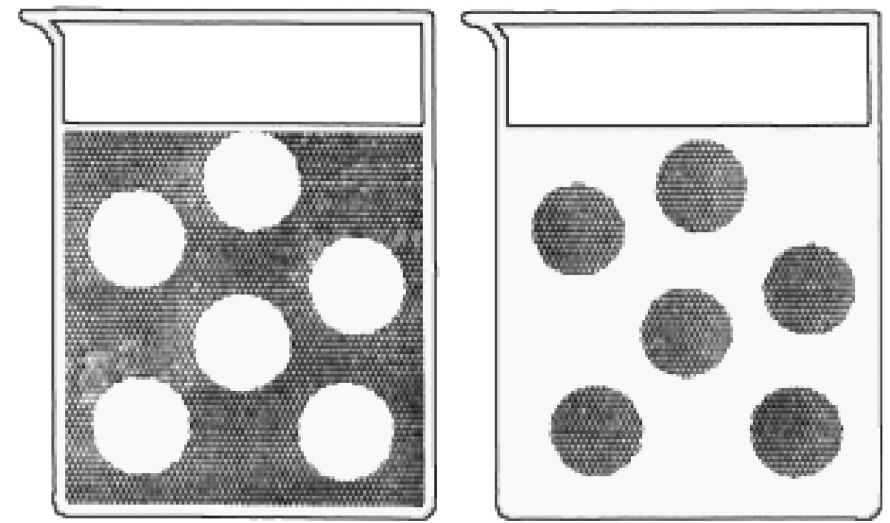
Figure 1: Dispersion of water droplets in oil and oil in water